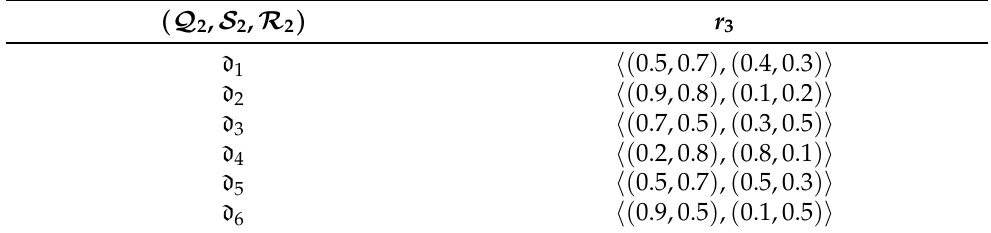
Table 7. Table for the 7-ROFBSS ( Q 2 , S 2 , R 2 )